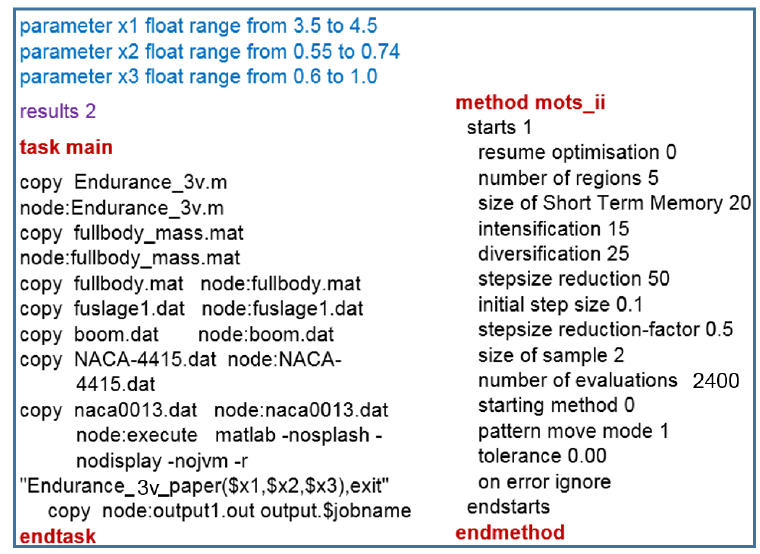
Figure 5. A simple Nimrod/O declarative file, which consists of four main sections: design variables, results, task, and the optimisation algorithm used.